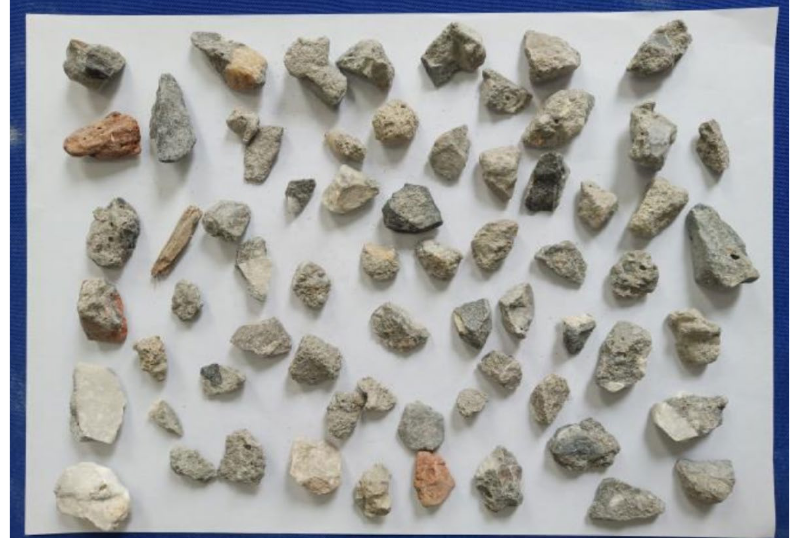
Figure 1. The raw RCA.